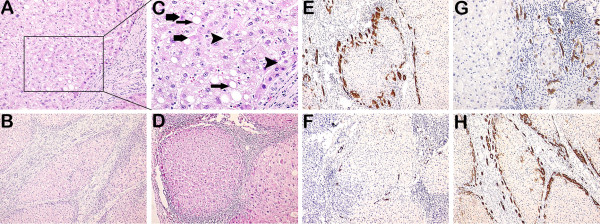
Immunostaining of DR, histopathology of necroinflammation and fibrosis/cirrhosis. (A, C) Ballooning degeneration (arrowheads), steatosis (thin arrows) and focal necrosis (thick arrows) were shown in the peritumoral parenchyma. (B) Cirrhosis and interface hepatitis were shown. (D) Fibrosis/cirrhosis and portal inflammation were shown. (E) Increased DR was around a nodule in the peritumoral tissue. (F) Decreased DR was around a nodule in the peritumoral tissue. (G) DR and necroinflammation were shown. Ballooning degeneration, steatosis and focal necrosis were nearby DR. Inflammatory cells were around DR in the portal tracts. (H) DR and cirrhosis were shown. DR was at the periphery of a cirrhotic nodule. (A and G 200×; C 400×; B, D, E, F and H 100×).